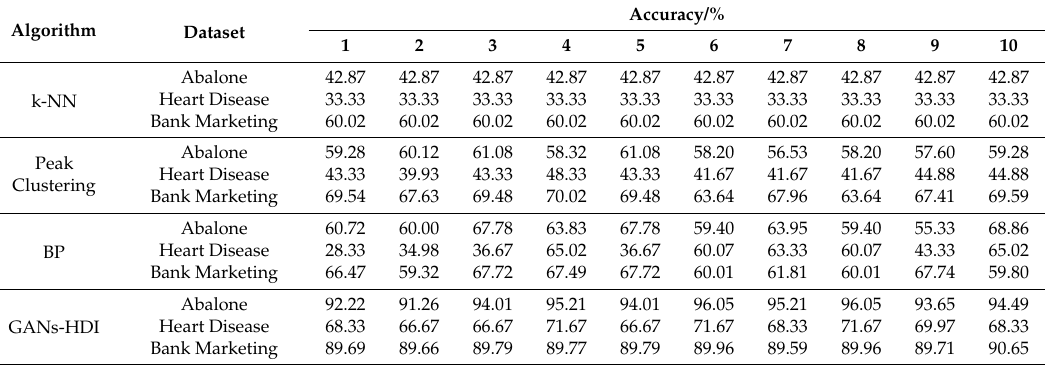
Table A1. Comparison detail information of four algorithms on UCI